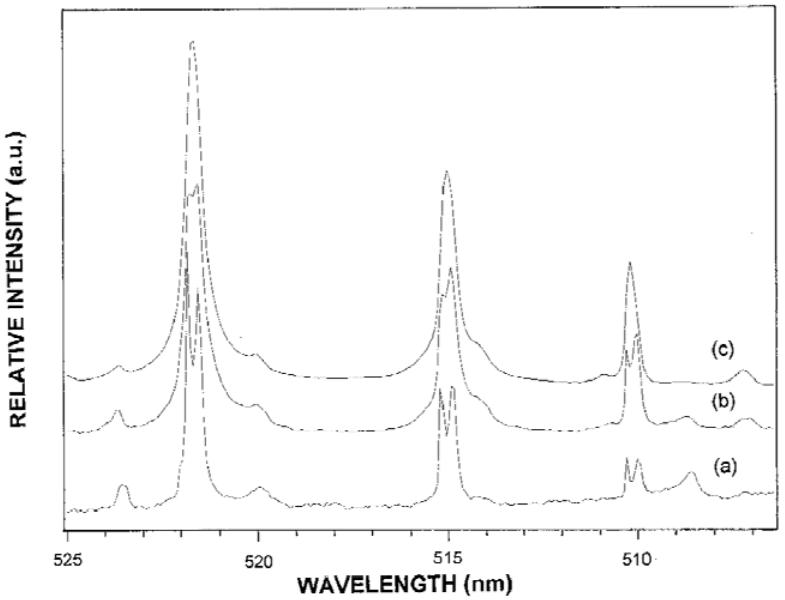
Figure 12. LIBS spectra of Cu in different atmospheres: (a) He, (b) Ne, and (c) Ar. Reprinted from reference